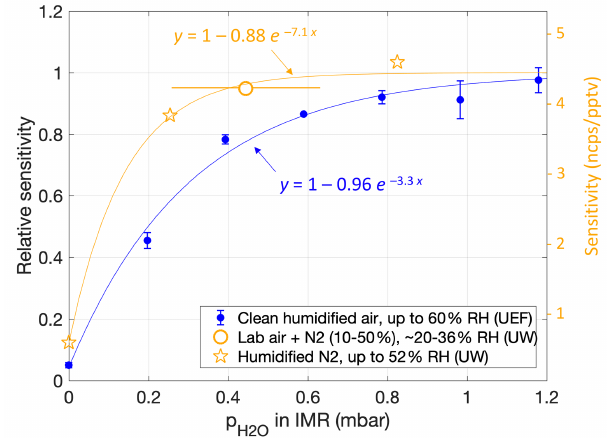
Figure 2. Humidity dependence of the sensitivity of NH 3 · C 6 D + the NH 3 mixing ratio, shown as a function of water partial pressure in the IMR as calculated from the humidity in the sample flow. Ion counts were normalized to the total reagent ion counts ([C 6 D + Orange markers are from calibration experiments at the University of Washington (UW) lab immediately after the HI-SCALE cam- paign. Bars for the lab air result indicate a sample RH range from 16% to 40% (i.e., including 4% uncertainty); sample RH values for results in N 2 (stars) were 0%, 16% and 52%. The right-hand scale also reports the corresponding sensitivities obtained from a temperature-controlled NH 3 permeation source. Blue markers are from experiments using a largely corresponding setup but with a different CIMS device at the University of Eastern Finland (UEF). Corresponding sample RH values are from 0% to 60% in steps of 10%, i.e., divergent from the UW results due to a smaller (dry) ionizer flow into the IMR. Lines are weighted fits of the form y = 1 − ae − bx .